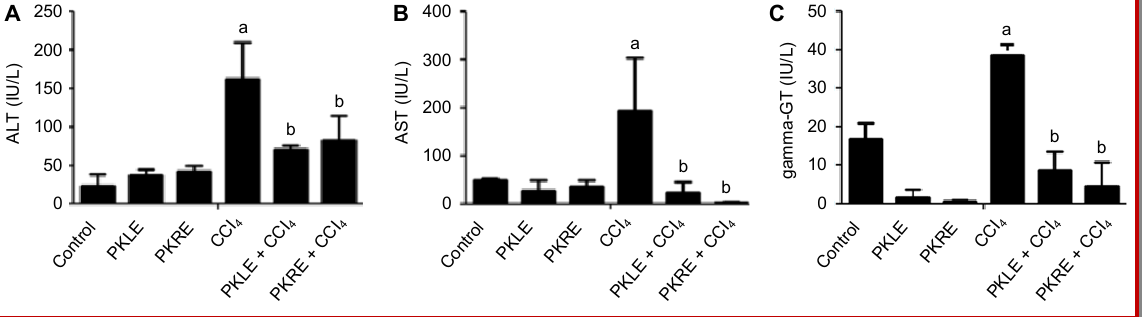
Figure 1: ALT (A), AST (B) and GGT (C) values of different groups; Data is represented as Mean ± SD; “a” Shows significant di f- ference Vs Control Group; “b” Shows significant difference Vs CCl 4 Group